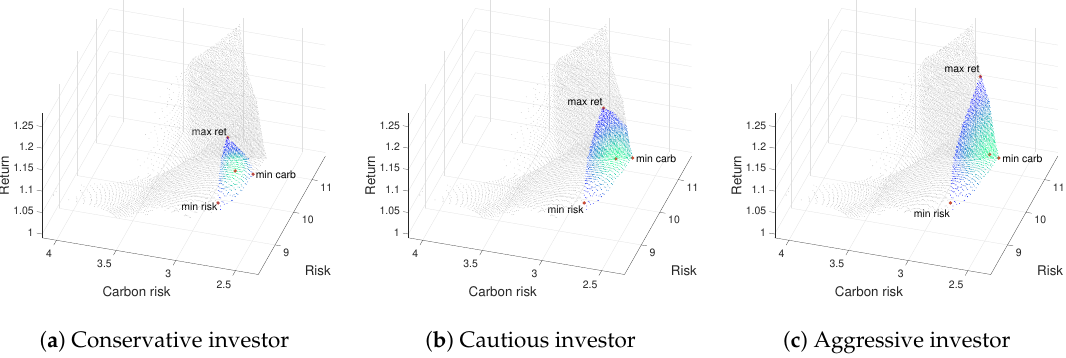
Figure 4. 3D Pareto fronts for a Strong Green Investor profile ( p s g ): on the left, for the conservative profile ( p c r ); on the center for the cautious investor ( p k r ); and on the right for the aggressive profile ( p a r